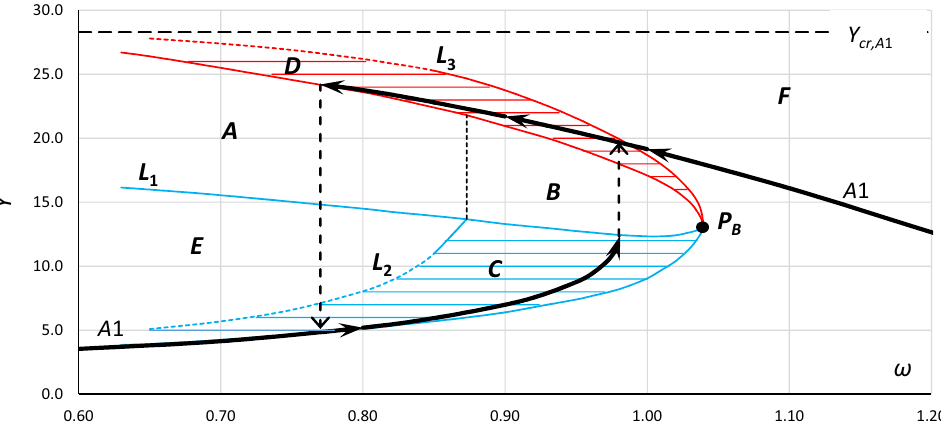
Figure 2. Bistability and unstable solution areas of a Duffing equation for case A1 (Table 1), calculated with the use of Eq. (1) with damping coefficient η = 0.10 and frequency response curves for a specific value of excitation coefficient (line